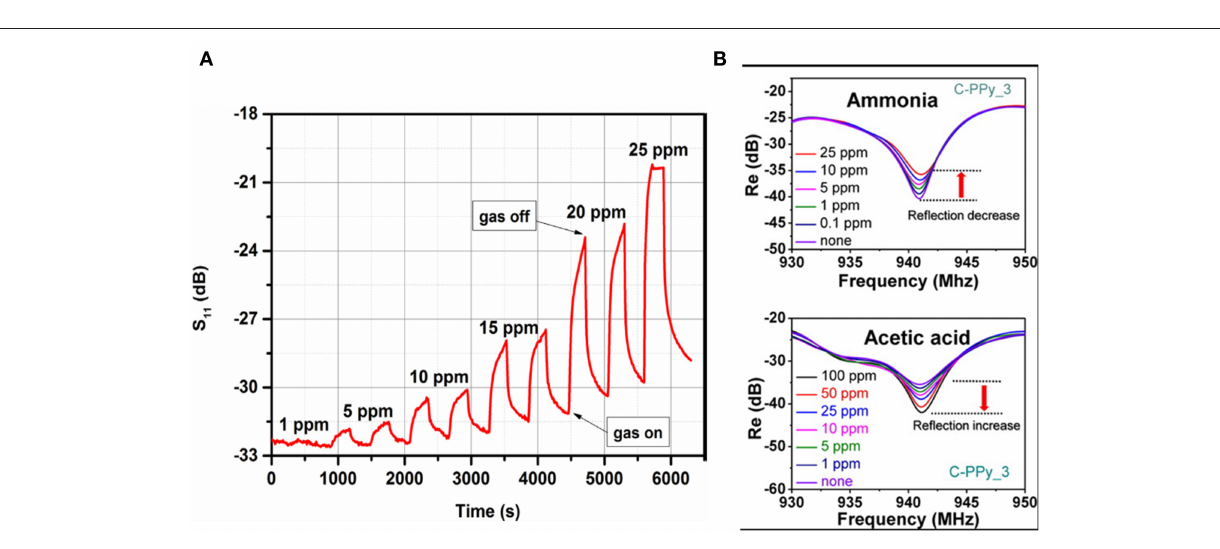
the sensor performance, the imaginary part of the parameter for a concentration at fixed frequency (Barochi et al.,